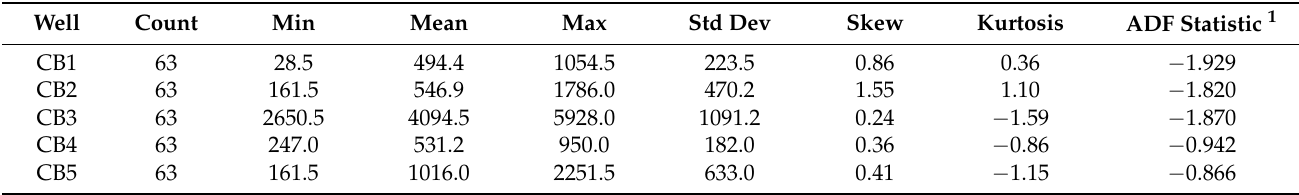
Table 1. Descriptive statistic of Cambay Basin